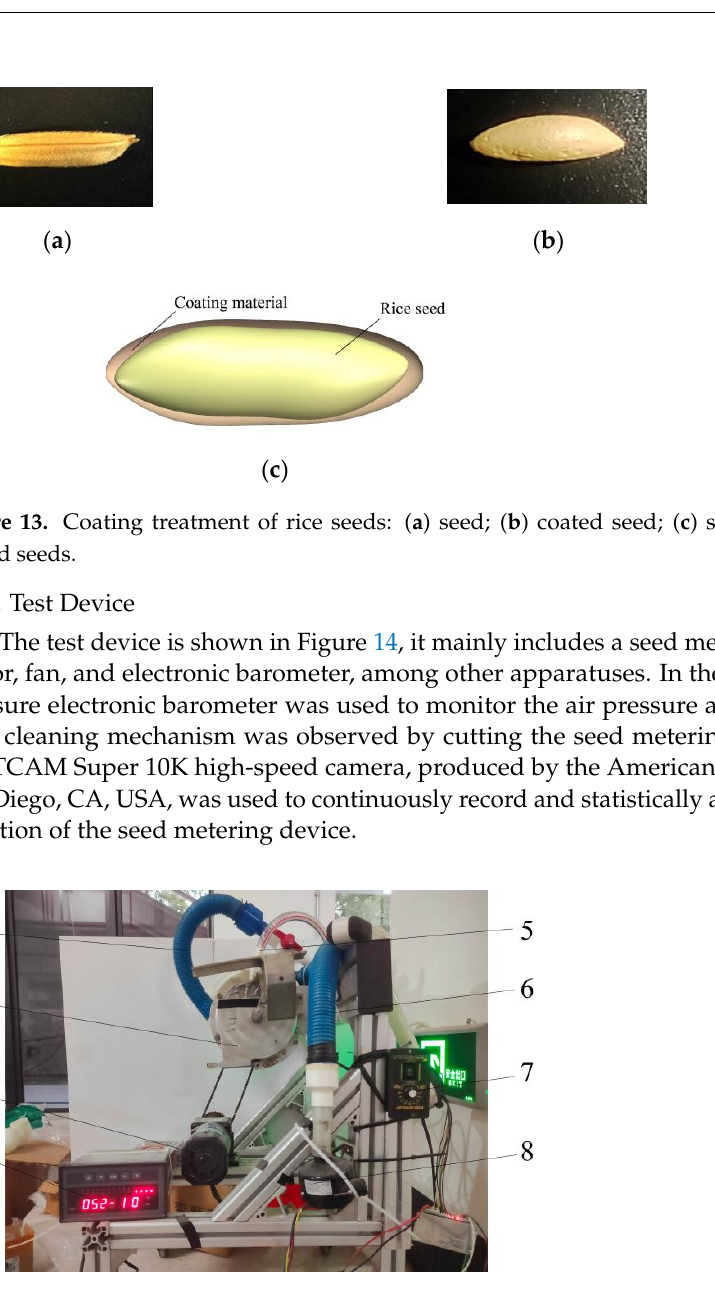
Figure 14. Test bed for seed metering device: ( 1 ) air pressure display; ( 2 ) drive motor; ( 3 ) seed metering device; ( 4 ) positive pressure pipeline; ( 5 ) air flow pipeline for seed cleaning; ( 6 ) negative pressure pipeline; ( 7 ) motor governor; ( 8 ) fan.